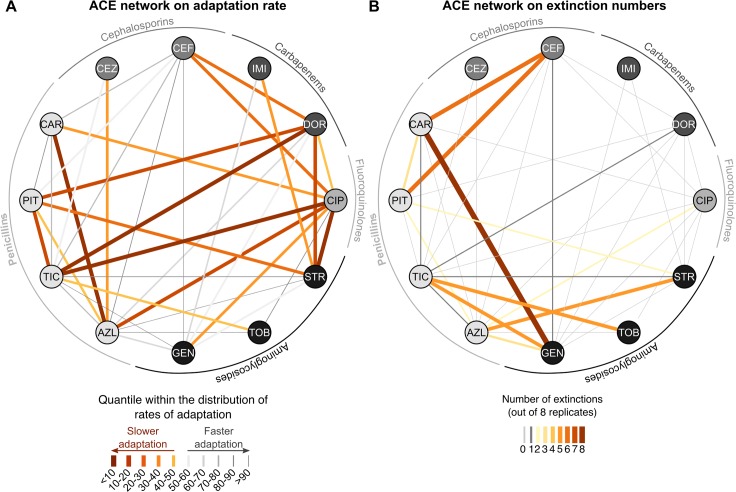
The ACE networks.(A) ACE network built from the rates of adaptation of surviving populations in the combination environment. The color and thickness of the lines (links) formed between the drugs (nodes) reflect the quantiles within which the inferred adaptation rates are found relative to the entire distribution: orange thick lines denote the combinations with the slowest adaptation rates (one of the aims of treatment efficacy), and grey thin lines highlight those with fast adaptation. (B) ACE network on the number of extinction events observed in the combination treatments. Thickness and color of the links represent the number of extinct populations, ranging from 0 (grey) to 8 (dark orange). Adaptation rates and extinction frequencies are inferred from the growth characteristics provided in S4 Data. ACE, antibiotic combination efficacy; AZL, azlocillin; CAR, carbenicillin; CEF, cefsulodin; CEZ, ceftazidime; CIP, ciprofloxacin; DOR, doripenem; GEN, gentamicin; IMI, imipenem; PIT, piperacillin + tazobactam; STR, streptomycin; TIC, ticarcillin; TOB, tobramycin.